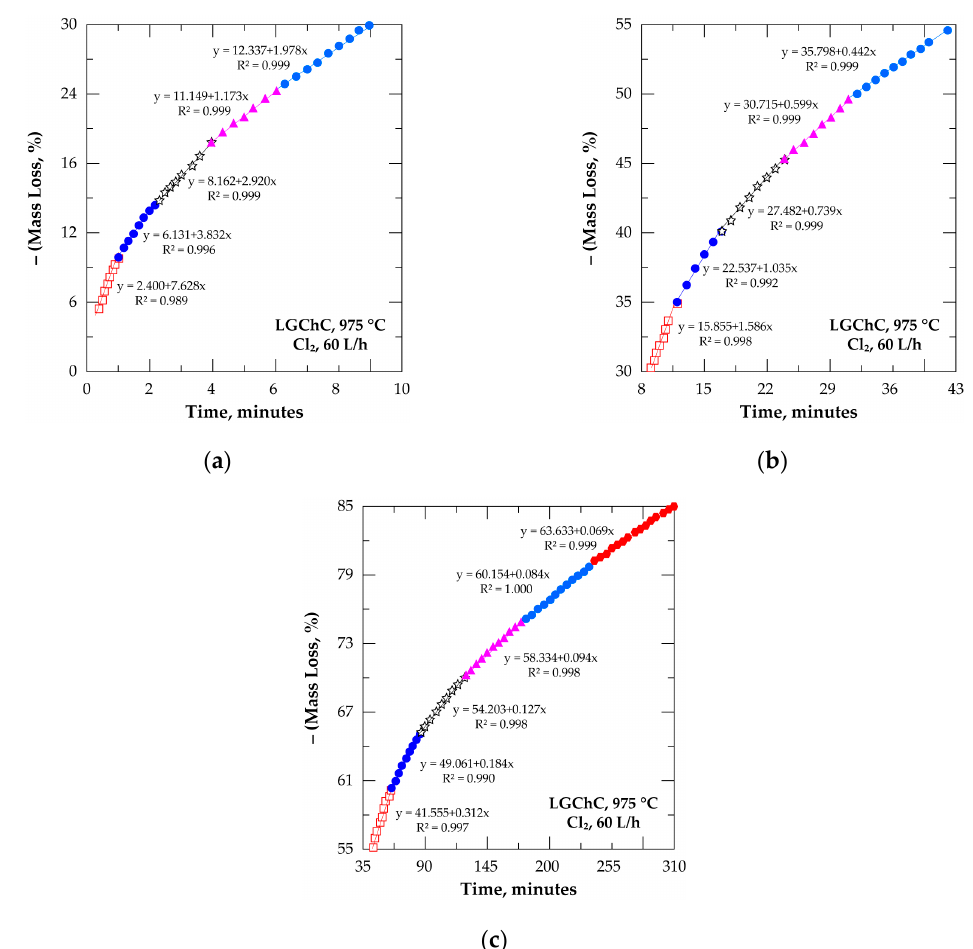
Figure 8. Plot of %ML versus time gathered with mean reaction rates calculated in increments of 5% ML during treatment of LGChC in chlorine at 975 °C: ( a ) 5–30% ML; ( b ) 30–55% ML; ( c ) 55–85% ML. The color markers are used to distinguish the segments of the %ML curves for which the linearization has been made for the calculation of the reaction rate.